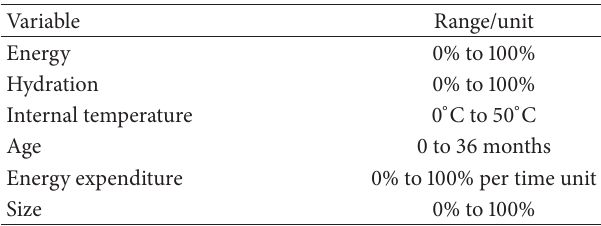
Table 2: Player’s lizard main